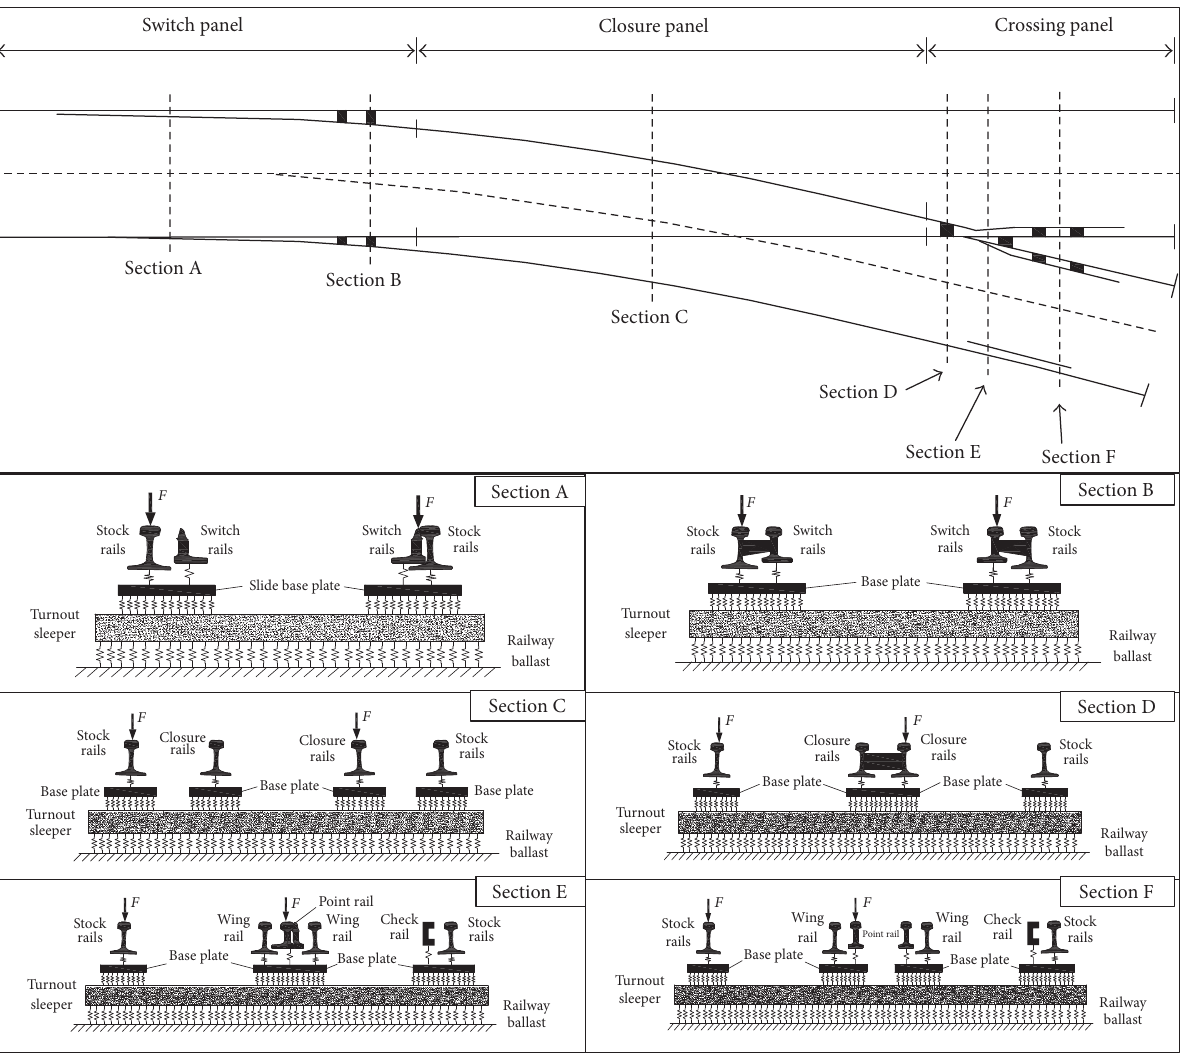
Figure 1: Characteristics of a high-speed turnout